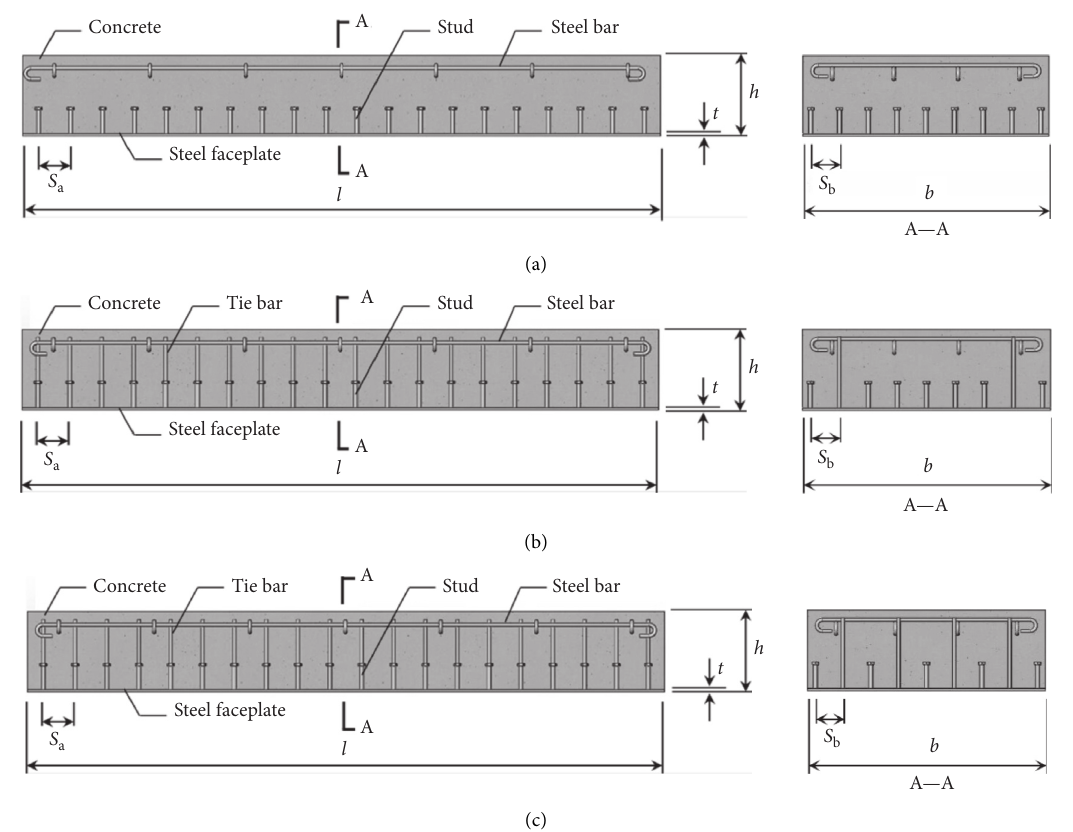
Figure 2: Section detail drawings: (a) Section 1 (except HSC2-7 and HSC2-8); (b) Section 2 (for HSC2-7); (c) Section 3 (for